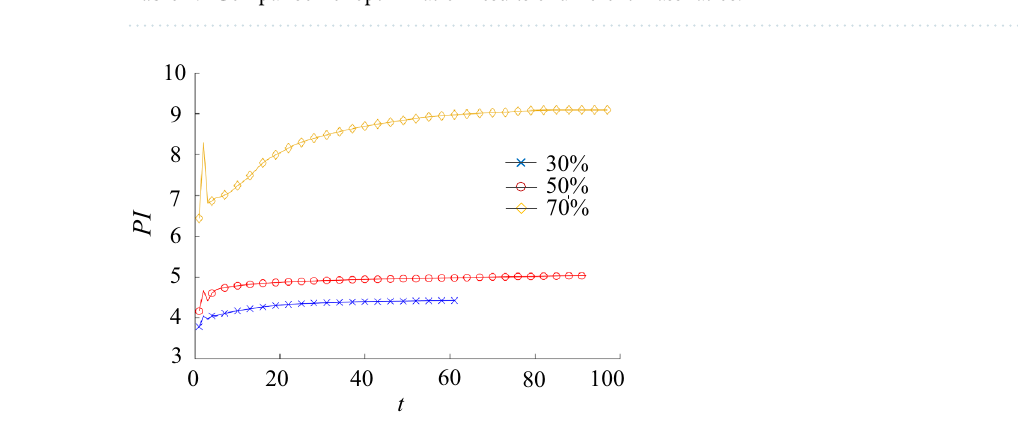
Figure 9. The performance index history curve under different material removal ratio condition.